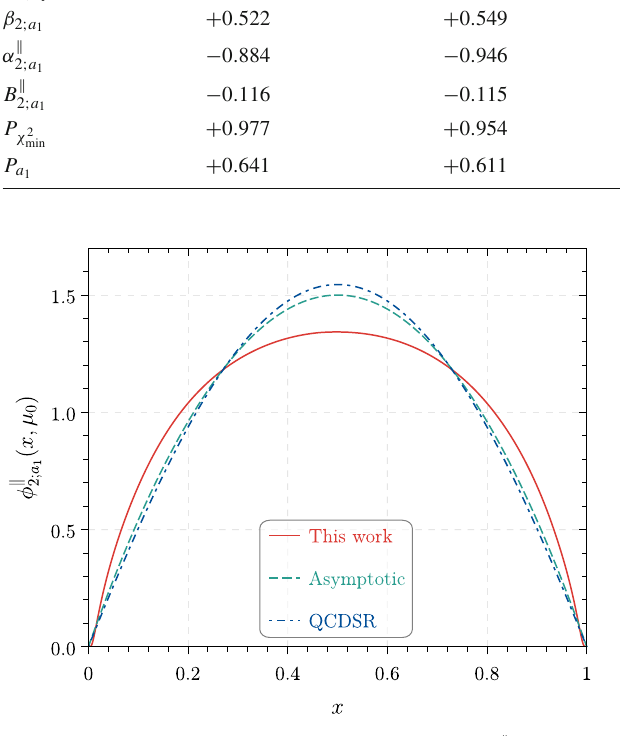
Fig. 3 The a 1 ( 1260 ) -meson longitudinal twist-2 LCDA φ As a comparison, the QCDSR [15,61] and the asymptotic curves are also